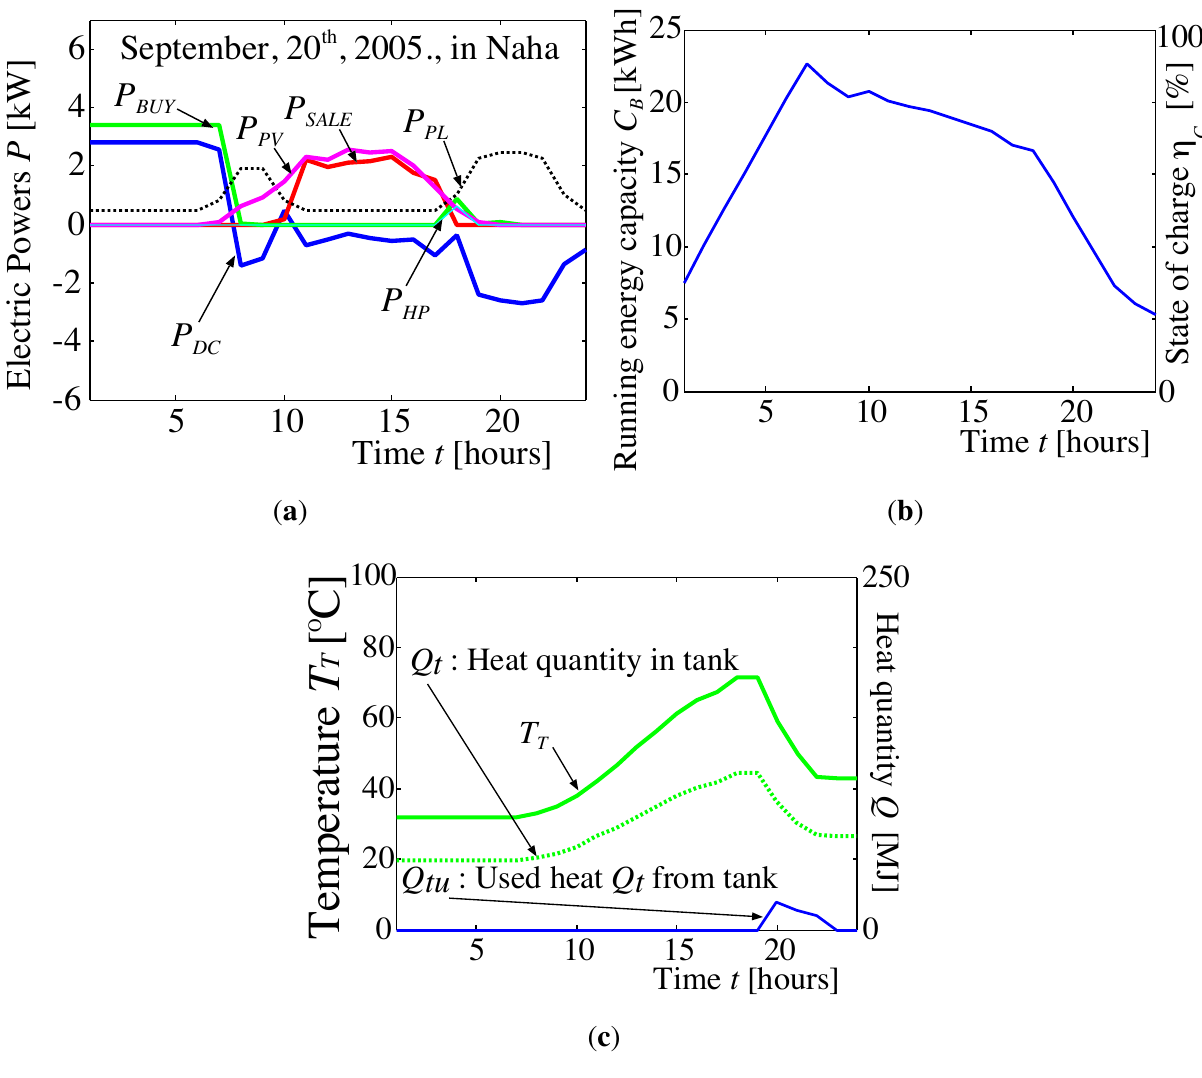
Figure 5. Simulation results (sunny day, case 3: re-planning operation). ( a ) Optimized result; ( b ) Battery; ( c ) Temperature of tank and used heat